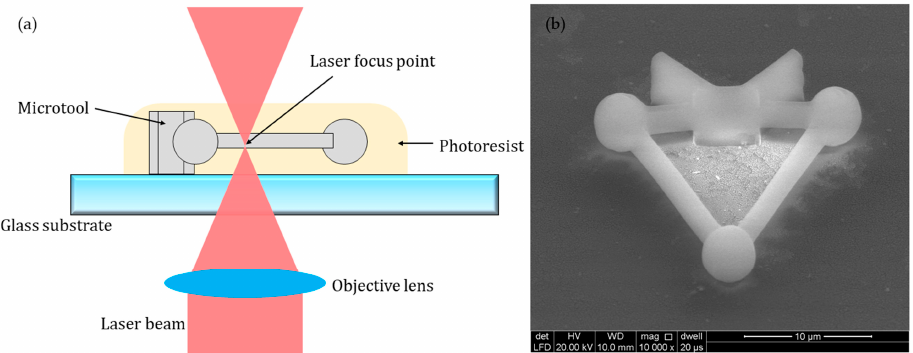
Figure 2. Fabrication of the microtool. ( a ) Schematics of the 3D printing process. ( b ) Micrograph of the microtool coated with a 5 nm-thick gold layer under an environmental scanning electron microscope (ESEM).